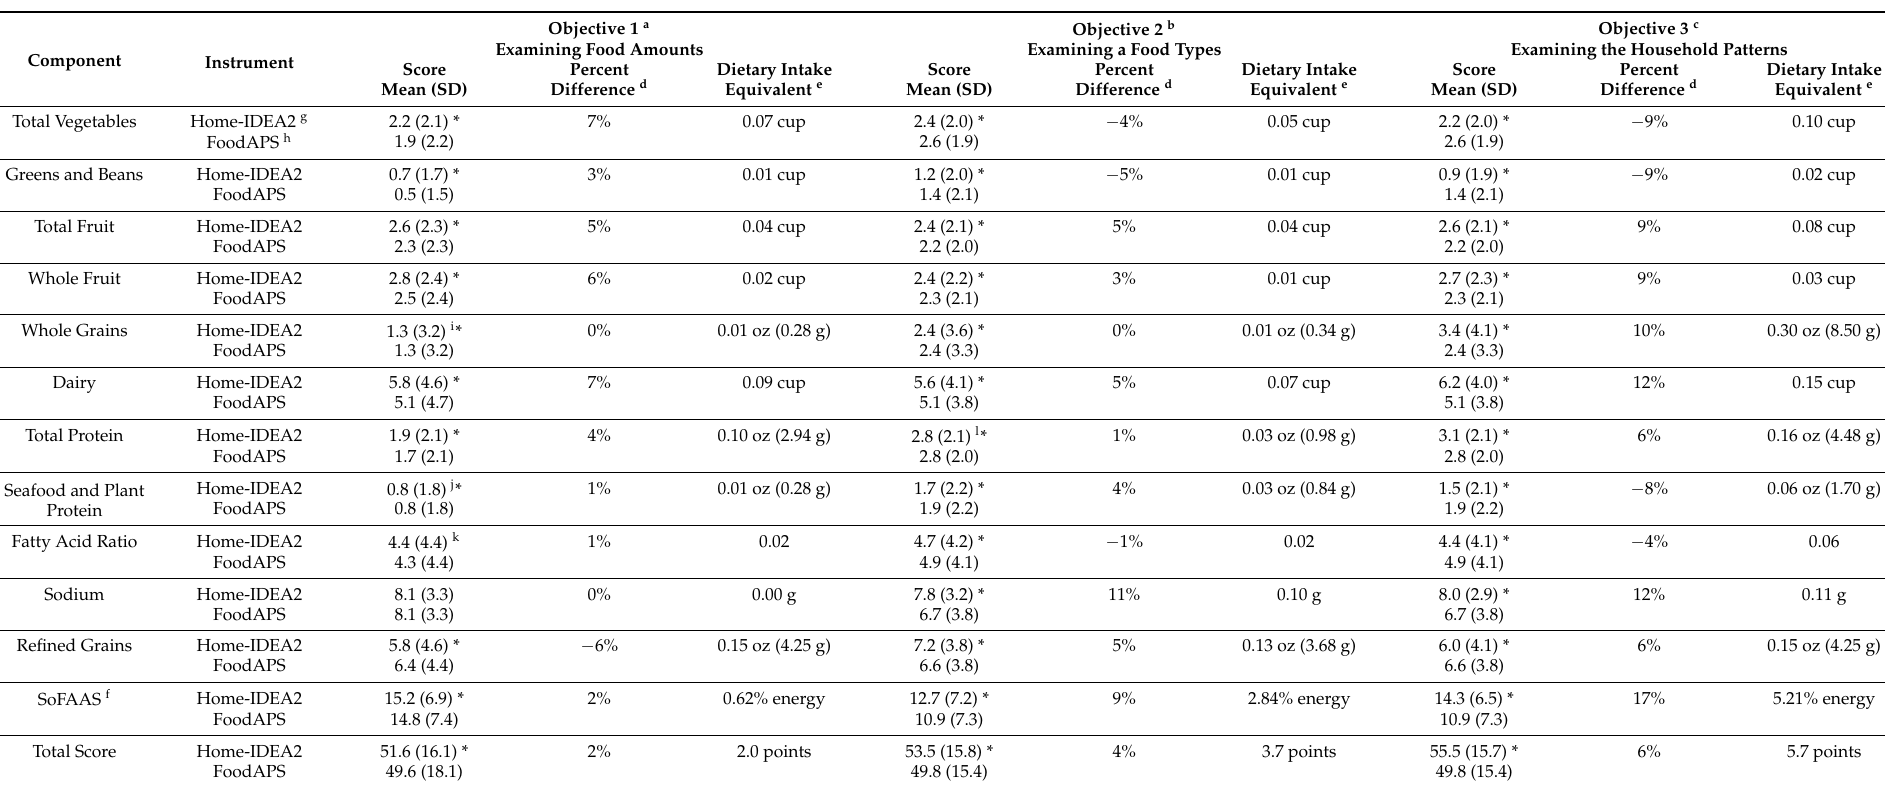
Table 4. Means, percent differences, and dietary intake equivalents for the Healthy Eating Index (HEI) component and total scores for each study objective.